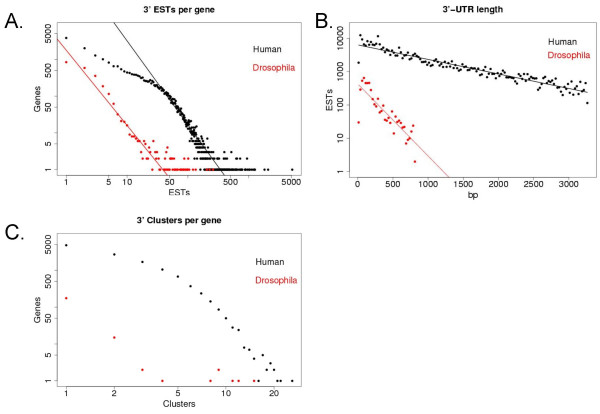
Distribution of 3' EST tags in human and Drosophila melanogaster genomes. A: Distribution of trusted tags per gene. In both species, the distribution of tags per gene follows a power law, with similar exponents (-2.29 for human tags and -2.05 for Drosophila tags). B: 3'UTR length distributions, in human and Drosophila genes, the average length for humans is 995 bp, for Drosophila it is 200 bp. Each point is the number of 3'UTRs of given length. C: Number of polyadenylation clusters in genes having more than 1 cluster, human genes have up to 25 separate 3P clusters (mean number of clusters per human gene is 2, 3, for drosophila genes 1.11).